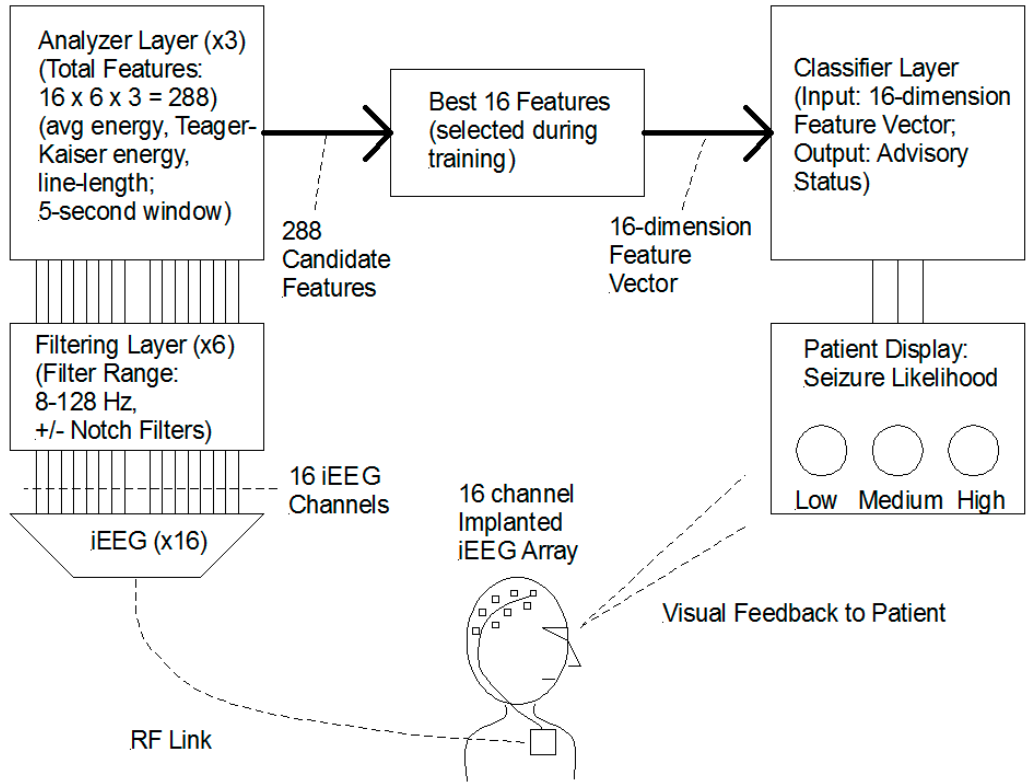
Figure 1. Block diagram depicting the functional structure of the Seizure Advisory System (SAS) Algorithm. A 16-channel implanted iEEG array provides real-time monitoring. A three-layer algorithm performs filtering, analysis, and classification. The combination of 16-channels (iEEG) with six filter options and three analyzer options, provides 288 possible features. During training, the 16 best performing features are selected for each patient. The classifier monitors the selected features and provides a real-time seizure estimate of seizure likelihood.